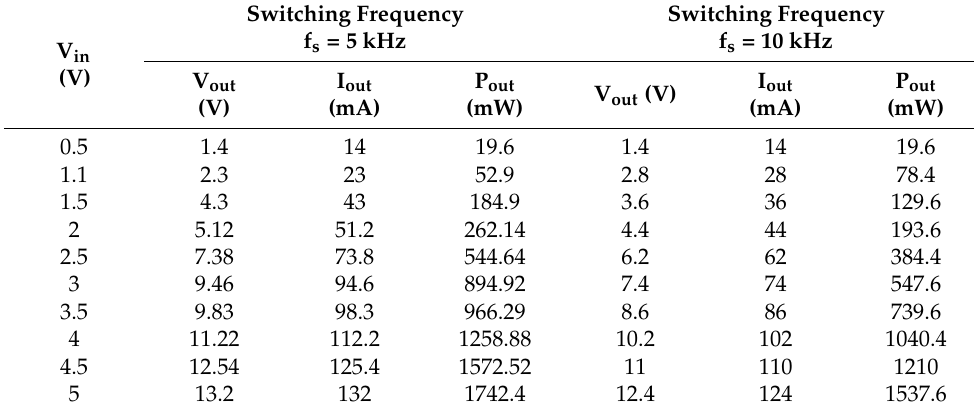
Table 12. Output voltage, current and power comparison at f s = 5 kHz and f s = 10 kHz.